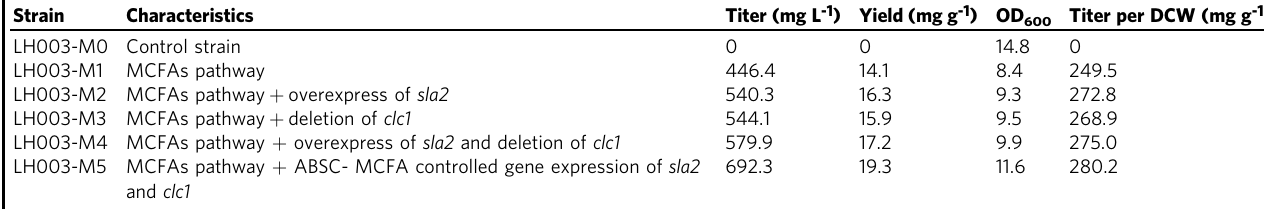
Table 2 Differences in control strain and engineered S. cerevisiae on MCFAs